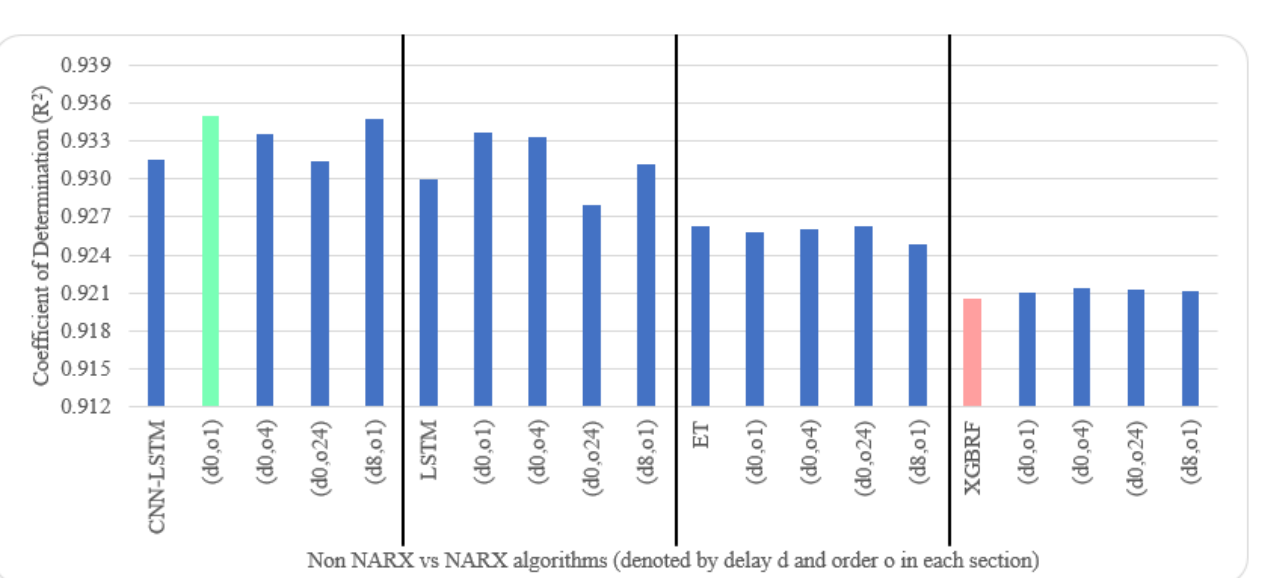
Figure 22. Evaluation results of non-NARX and NARX in terms of coefficient of determination for the Beijing dataset.